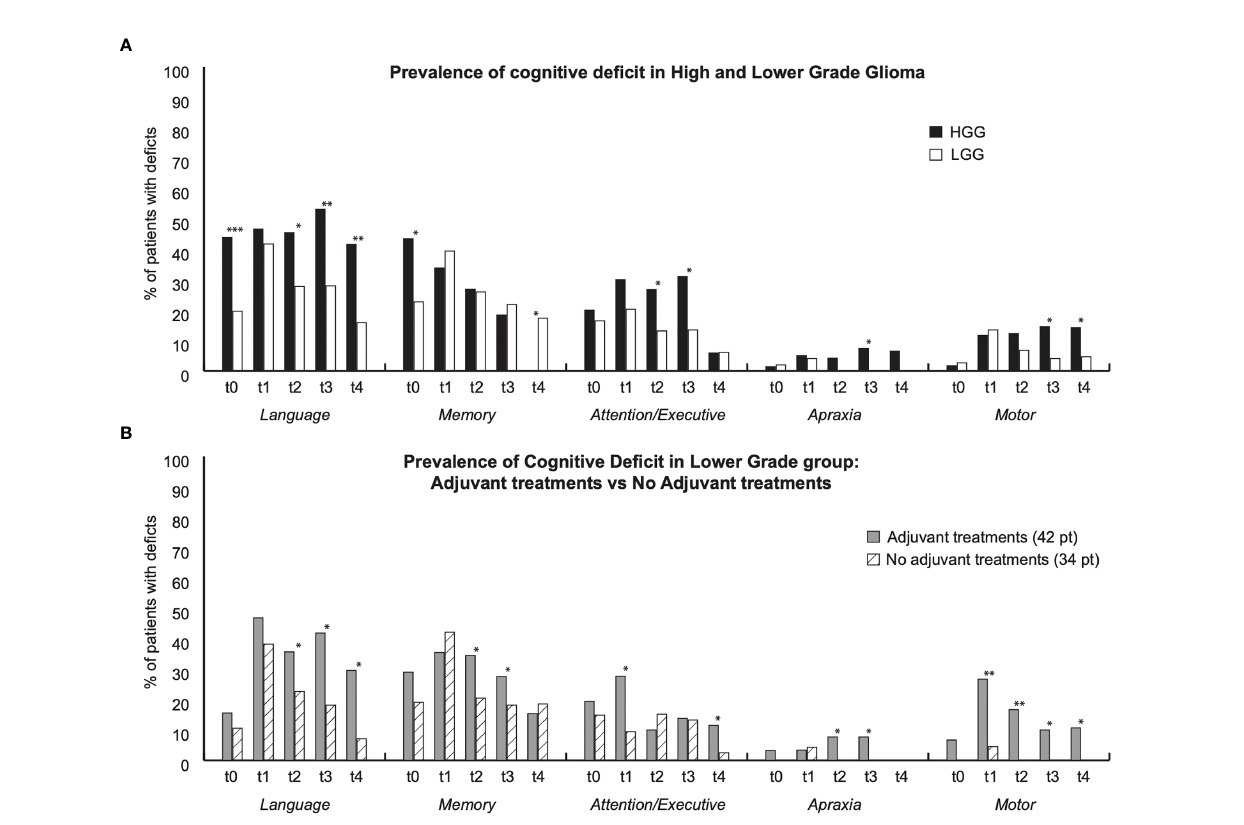
(White Bars); (B) Prevalence of de fi cits in Lower patients who underwent adjuvant treatments (grey bars) vs patients who did not undergo adjuvant treatment (white dashed bars). * indicate p < 0,05; ** p < 0,01; *** p <